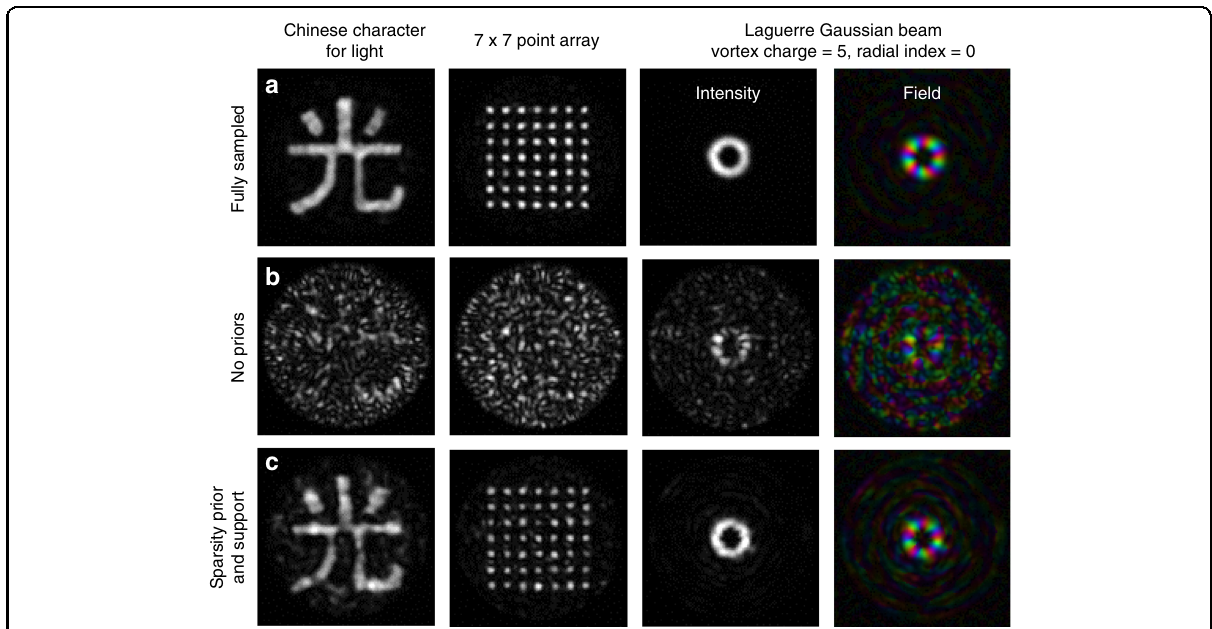
Fig. 4 Pattern projection using compressively recovered TMs. a Results of using a fully sampled TM to project, from left to right, the Chinese character for light, a 7 × 7 point array, and a Laguerre – Gaussian (LG) beam carrying a vortex charge of ‘ = + 5. The rightmost panels show the measured amplitude (brightness) and phase (colour) of the projected LG fi eld reconstructed using digital holography 26 by processing the interference pattern created by interference with a coherent plane-wave reference beam. The scale bar is the same as that used in Fig. 1. b When using an under- sampled TM ( c = 0.2) without priors, it is not possible to project the target patterns. c When the TM is reconstructed using both a sparsity prior and an estimated support, the TM fi delity is suf fi ciently high to successfully project the target